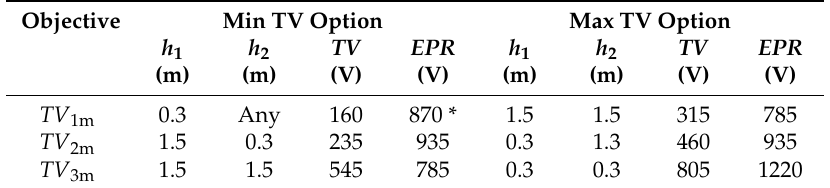
Figure 5. TV profiles along x direction for HoL model ρ 1 = 500 Ωm, ρ 2 = 100 Ωm, D 1 = 2 m, D 2 = 4 m, h 1 = 0.3 m; ( a ) surface layer thickness H = 2 m; and, ( b ) Surface layer thickness H = 1 m. Table 2. Sensitivity analysis results for ρ 1 = 500 Ω m, ρ 2 = 100 Ω m, H = 2 m, D 2 = 4 m, D 1 = 2 m. Objective